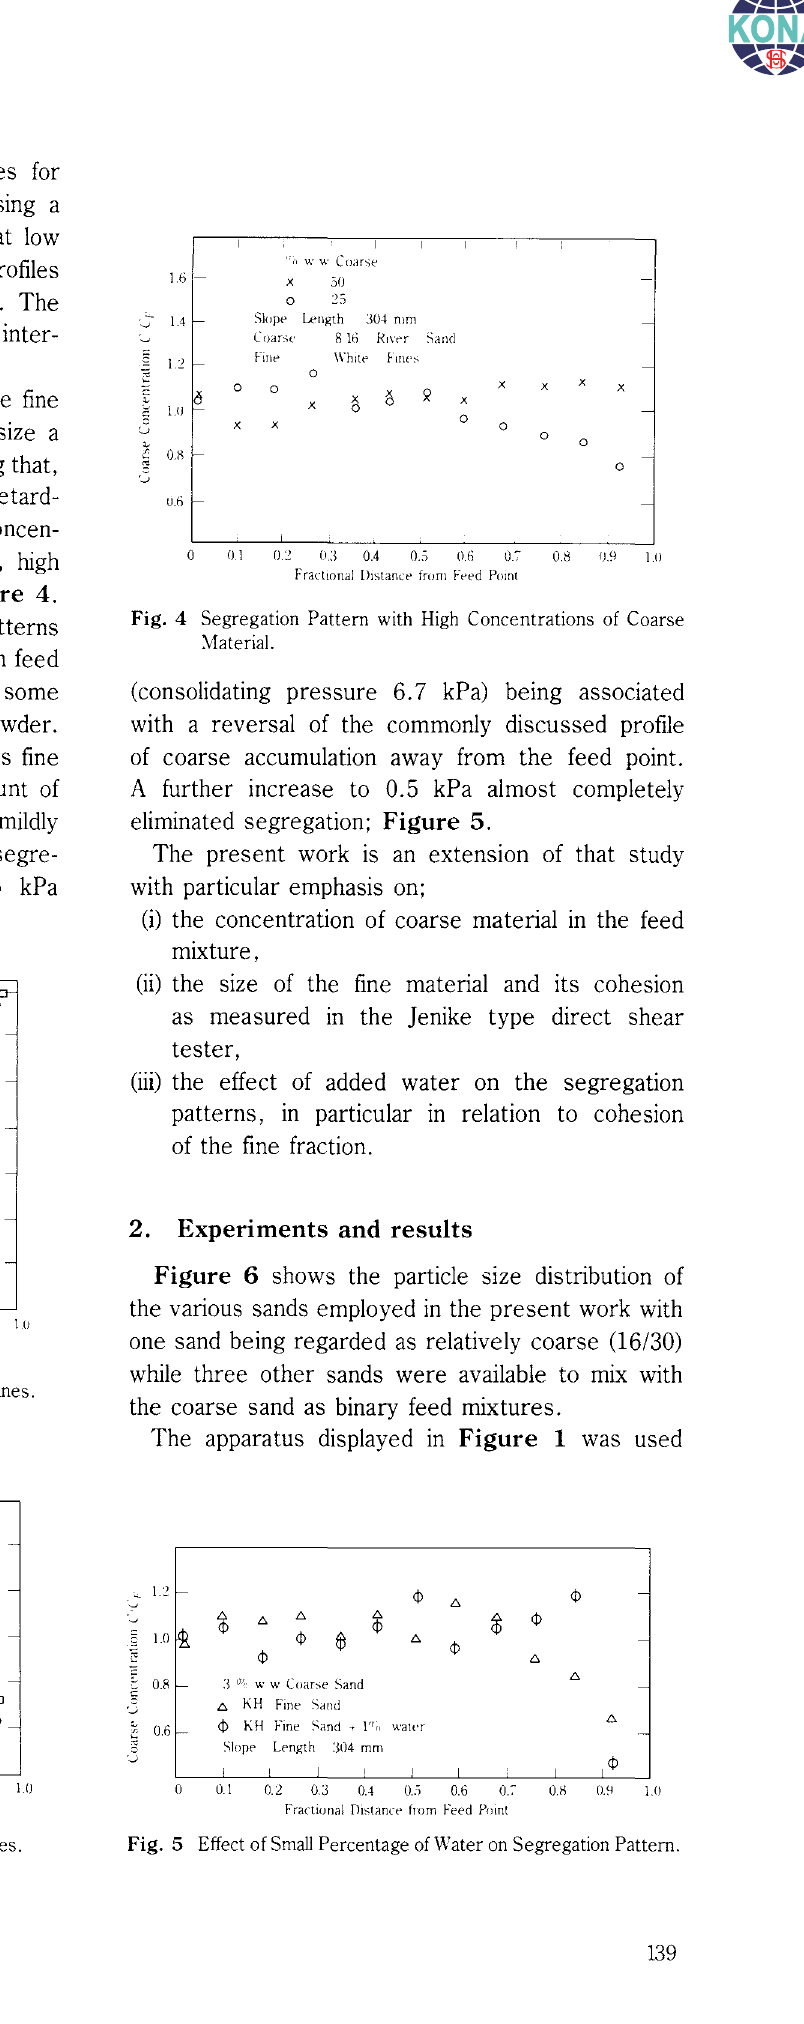
Fig. 5 Effect of Small Percentage of Water on Segregation